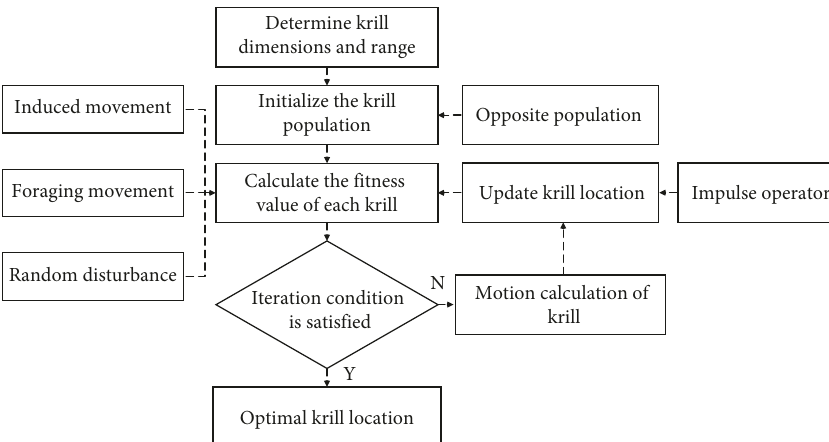
Figure 4: Flow chart of the NKH.